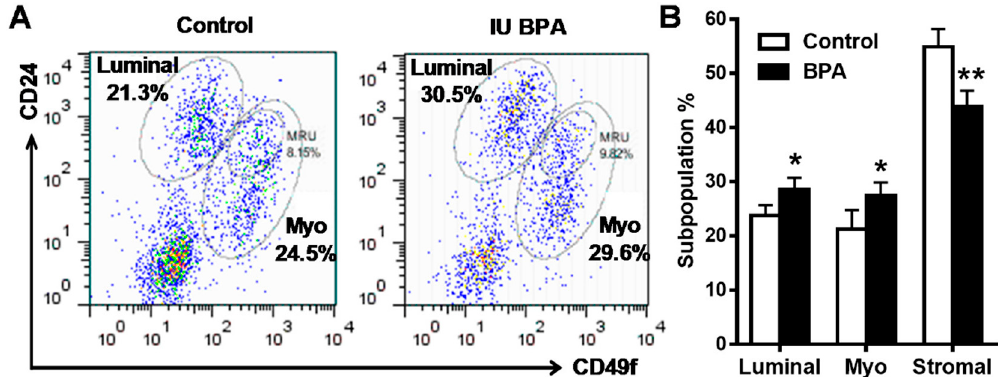
Figure 4. In utero exposure to low dose BPA a ff ects mammary cell subpopulations in MMTV-erbB2 transgenic mice. Primary mammary epithelial cells of MMTV-erbB2 mice (PND 35) from control and low dose BPA (500 ng / kg) groups were stained with fluorescent CD24 and CD49f antibodies and analyzed using FACS. Representative plots of epithelial cell populations from mice with di ff erent treatments are shown with the percentage of luminal, basal / myoepithelial, and MRU / MaSC cells indicated ( A ). The average subpopulation percentage of luminal, basal / myoepithelial, and stromal cells (CD24 low / CD49f low ) from control and BPA-treated mice are quantified in ( B ) (* p < 0.05; ** p < 0.01). 2.5. In Utero Exposure to Low Dose BPA Induces Crosstalk between ER and EGFR / erbB2